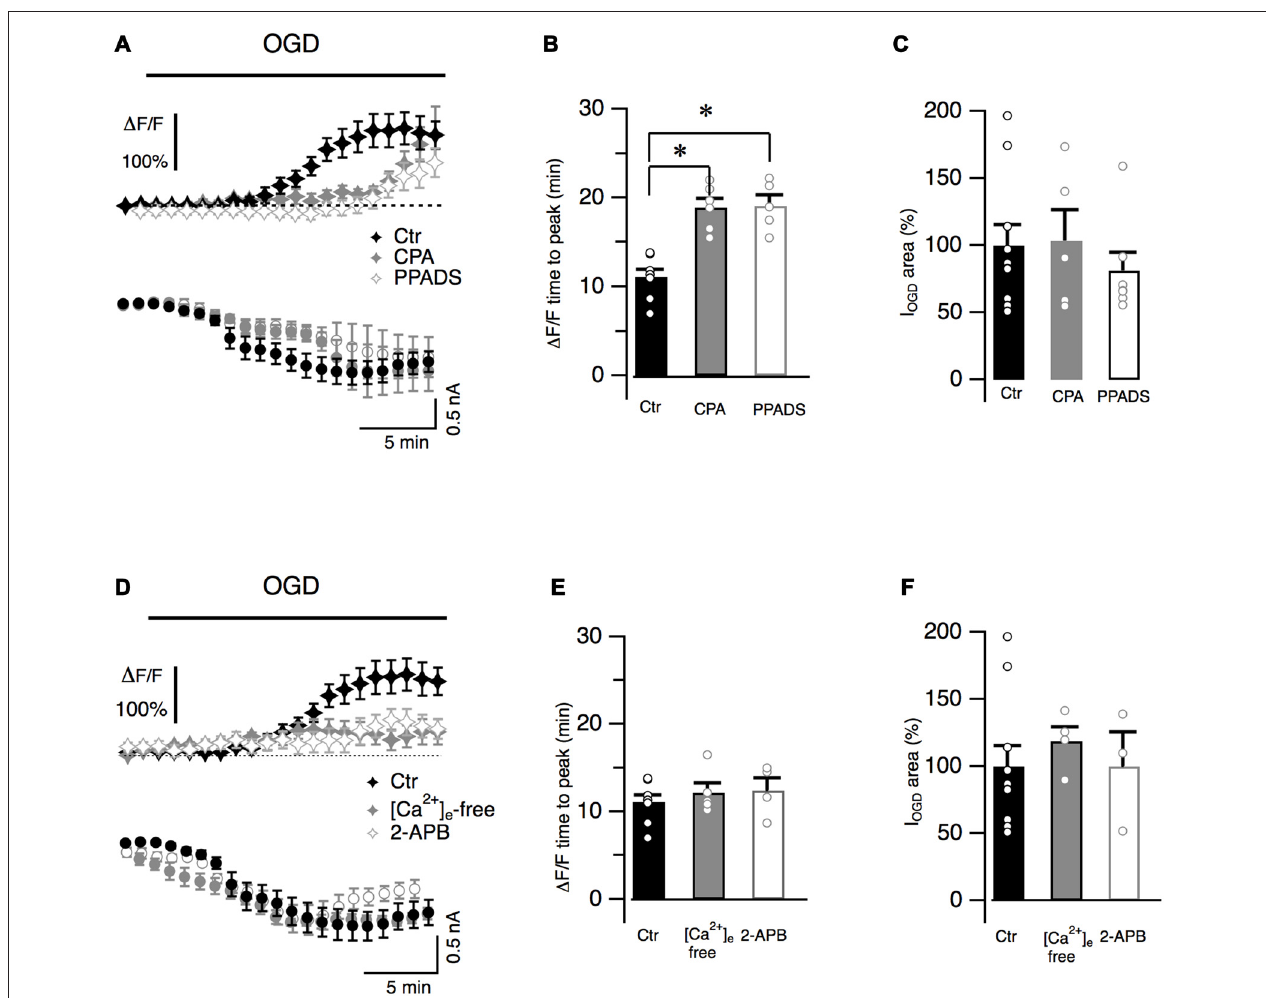
FIGURE 2 | Bergmann glia Ca 2 + raises during OGD are mediated by Ca 2 + release from internal stores and Ca 2 + entry from extracellular space. (A) Bergmann glial cells are loaded with Fluo4 (100 µ M) and changes in fluorescence are measured in radial processes during OGD. Averaged ∆ F/F values are plotted as a function of time in Ctr ( n = 11), after treatment with CPA (20 µ M), a blocker of intracellular Ca 2 + stores refilling ( n = 7) or with PPADS (100 µ M), a broad-spectrum inhibitor of P2 receptors ( n = 8). CPA and PPADS delayed the onset of intracellular Ca 2 + increase (top) without affecting the onset of I OGD (bottom). (B) Quantification of the effects of CPA ( P = 0.002, n = 6) and PPADS ( P = 0.0034, n = 5) on the kinetics of Ca 2 + raises. (C) Mean and individual values of I OGD area in control ( n = 11), CPA ( n = 5, P = 0.59) and in the presence of PPADS ( n = 7, P = 0.12). (D) Extracellular Ca 2 + -free solution (+EGTA 5 mM, n = 9) or 2-APB (100 µ M, n = 7), a blocker of store operated Ca 2 + entry, dramatically reduces OGD-induced Ca 2 + transients observed during OGD (Ctr, n = 11). (E) The time to the fluorescence peak is not affected by these treatments ( P = 0.88, n = 5 for Ca 2 + -free solution and P = 0.27, n = 4, for 2-APB when compared to control ( n = 8)). Note that the inward